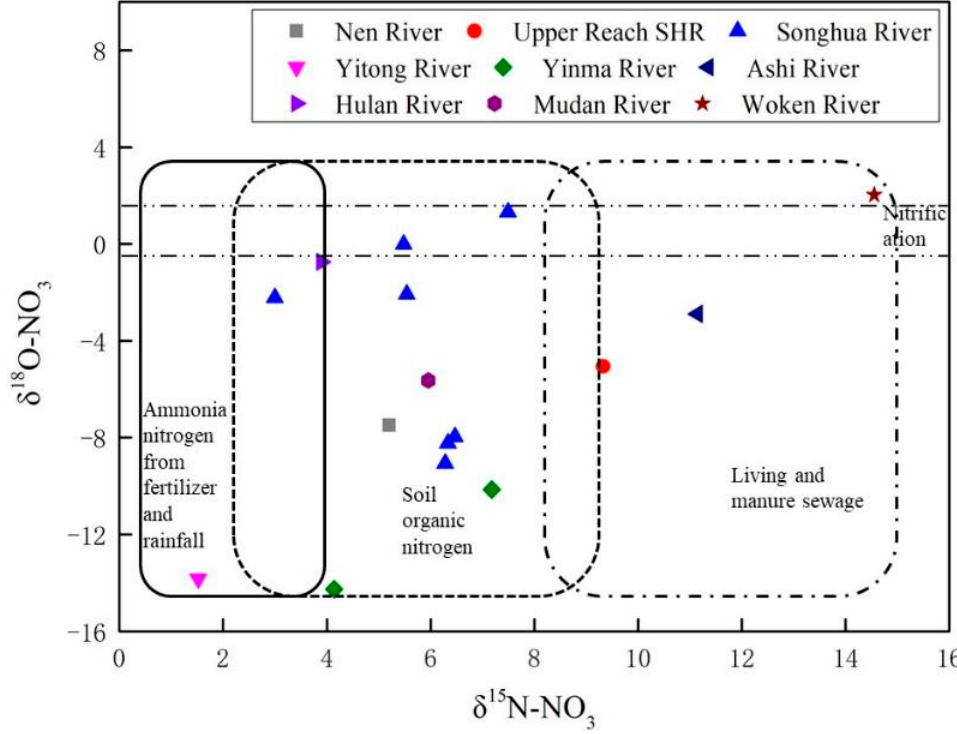
Figure 6. The relationship between δ 15 N and δ 18 O values of nitrate in the SHR during flat flow season. flow